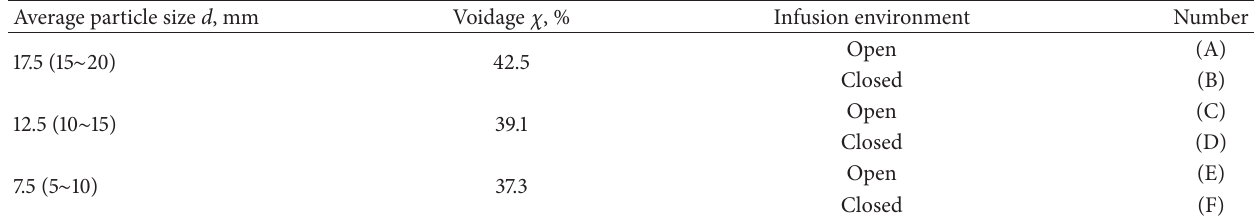
Table 2: Grouping of experimental